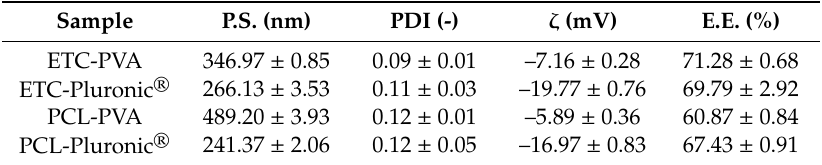
Table 1. Characterization by laser light scattering, electrophoretic movement, and encapsulation e ffi ciency of polymeric